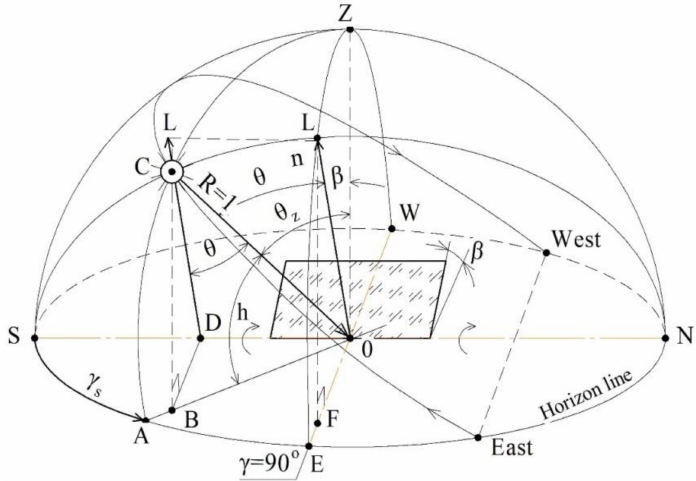
Figure 9. Scheme for measuring of the parameters of irradiation of the surface while it rotates around the horizontal axis “north–south” HNS axis tracker—designed based on